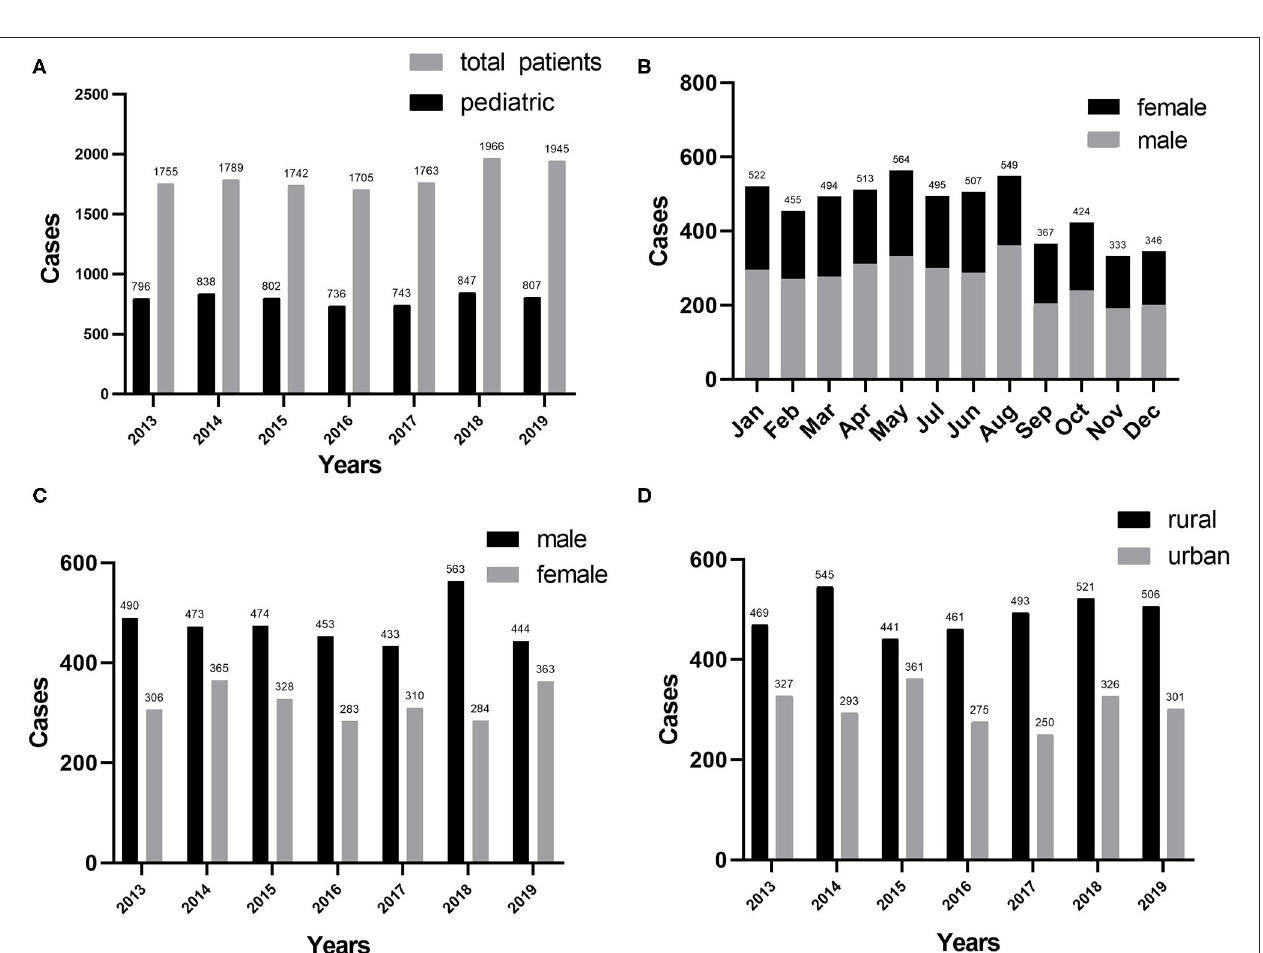
with 38.30% in the urban area and 61.70% in the